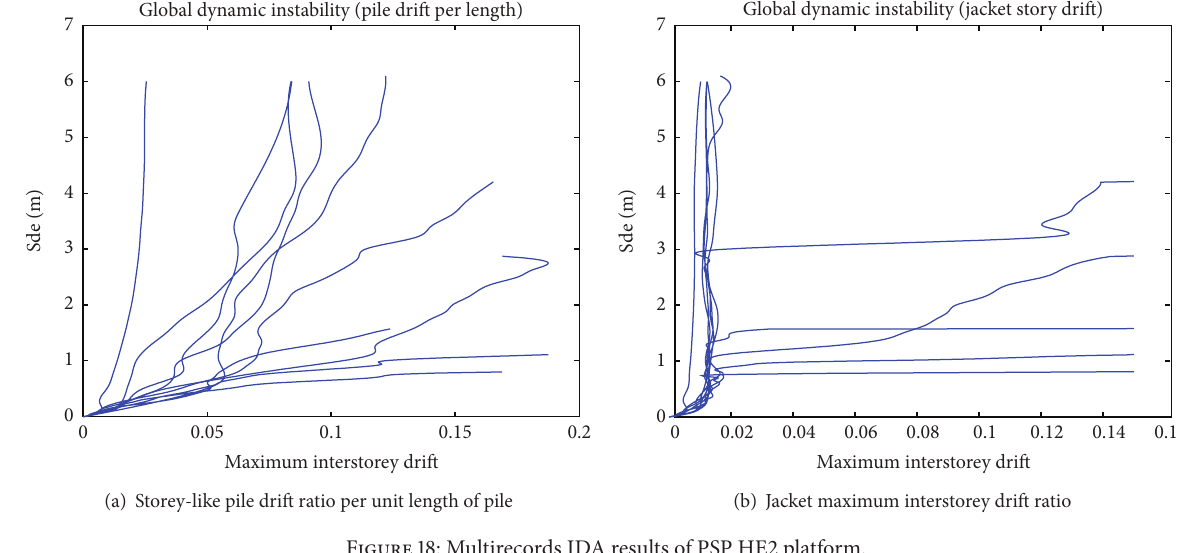
Figure 18: Multirecords IDA results of PSP HE2 platform.